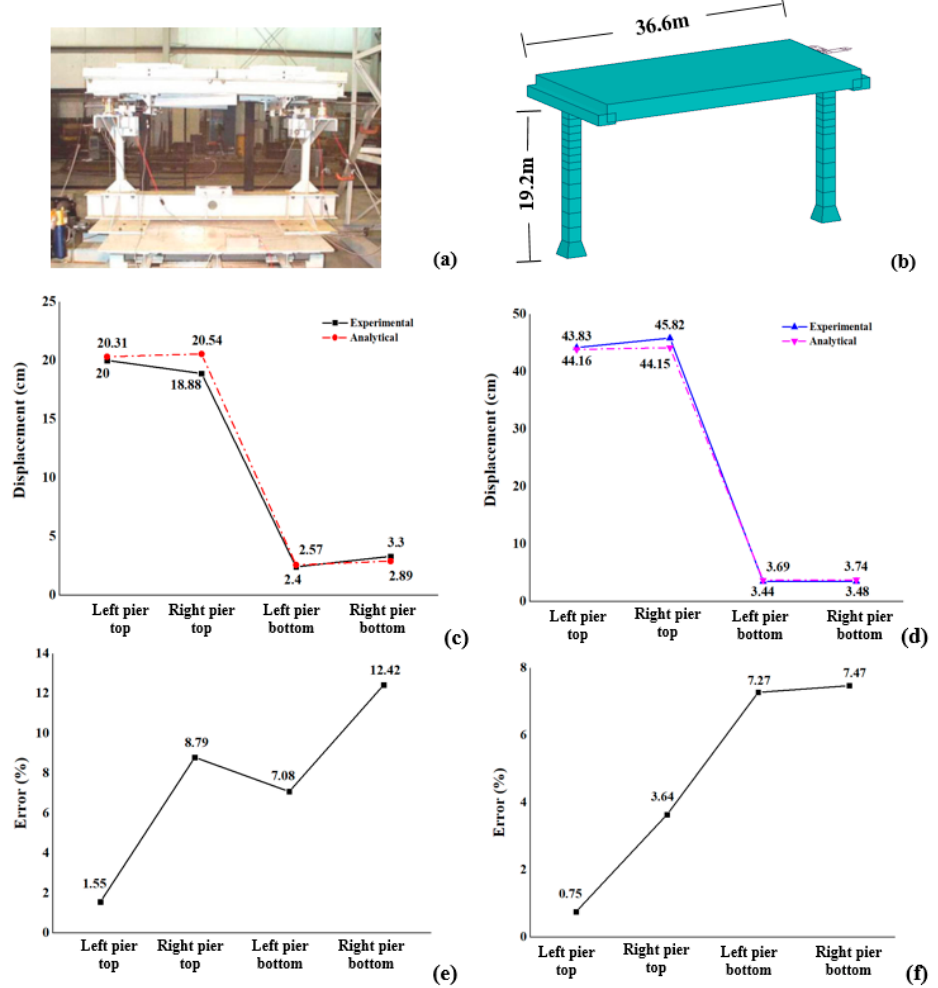
Figure 6. Models and results: ( a ) experimental model, ( b ) analytical model, ( c ) seismic response under El Centro earthquake, ( d ) seismic response under Northridge earthquake, ( e ) error analysis of the test and numerical simulation (El Centro earthquake), and ( f ) error analysis of the test and numerical simulation (Northridge earthquake).